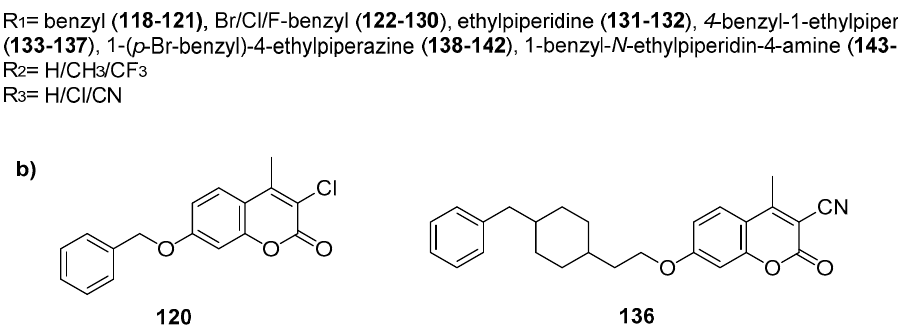
Figure 44. ( a ) General structure of compounds 118 – 146 ; ( b ) chemical structure of compounds 120 and 136.